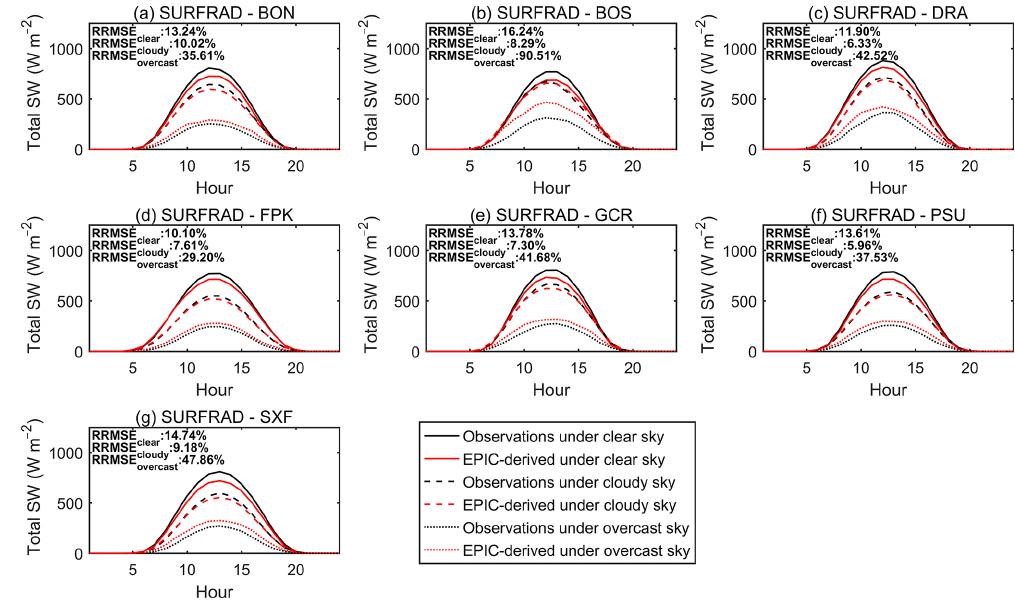
Figure 4. Diurnal variations in both EPIC- and ground-based total SWs, averaged, from June 2015 to June 2019 for different sky conditions at seven SURFRAD sites.